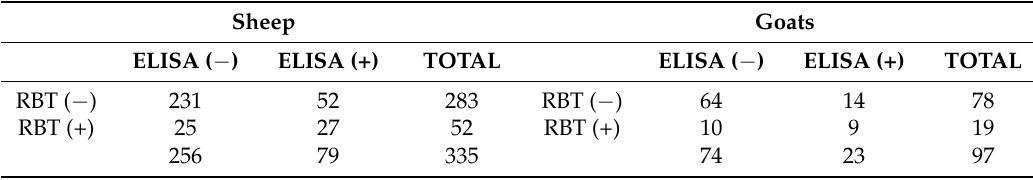
Table 1. Serological detection of antibodies to Brucella among 432 small ruminants (335 sheep and 97 goats) from Duhok Province (Iraq) using the Rose Bengal test (RBT) and indirect enzyme-linked immunosorbent assay (iELISA). Sheep Goats ELISA ( − ) ELISA (+) TOTAL ELISA ( − ) ELISA (+) TOTAL RBT ( − ) 231 52 283 RBT ( − ) 64 14 78 RBT (+) 25 27 52 RBT (+) 10 9 19 256 79 335 74 23 97 (+) positive; ( − )